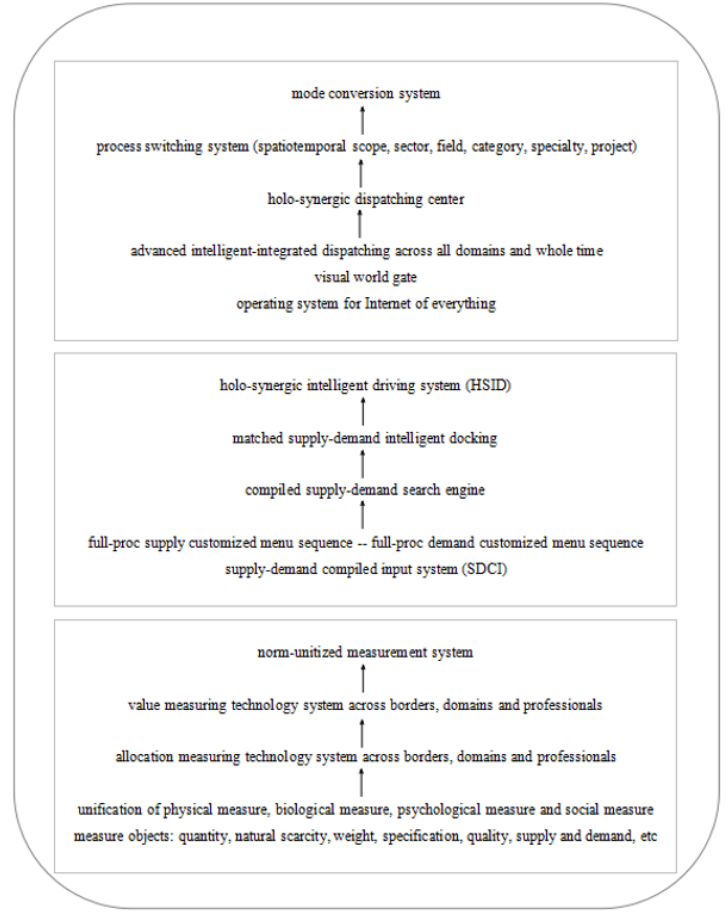
Fig. 6. Global service dispatcher with three functional modules. (1) unified normative measurement across borders, domains and levels Dimensional norm / attribute synthesis / weight analysis / unified processing / configuration measurement / efficacy analysis / system synthesis / value measurement / whole process analysis / whole course processing